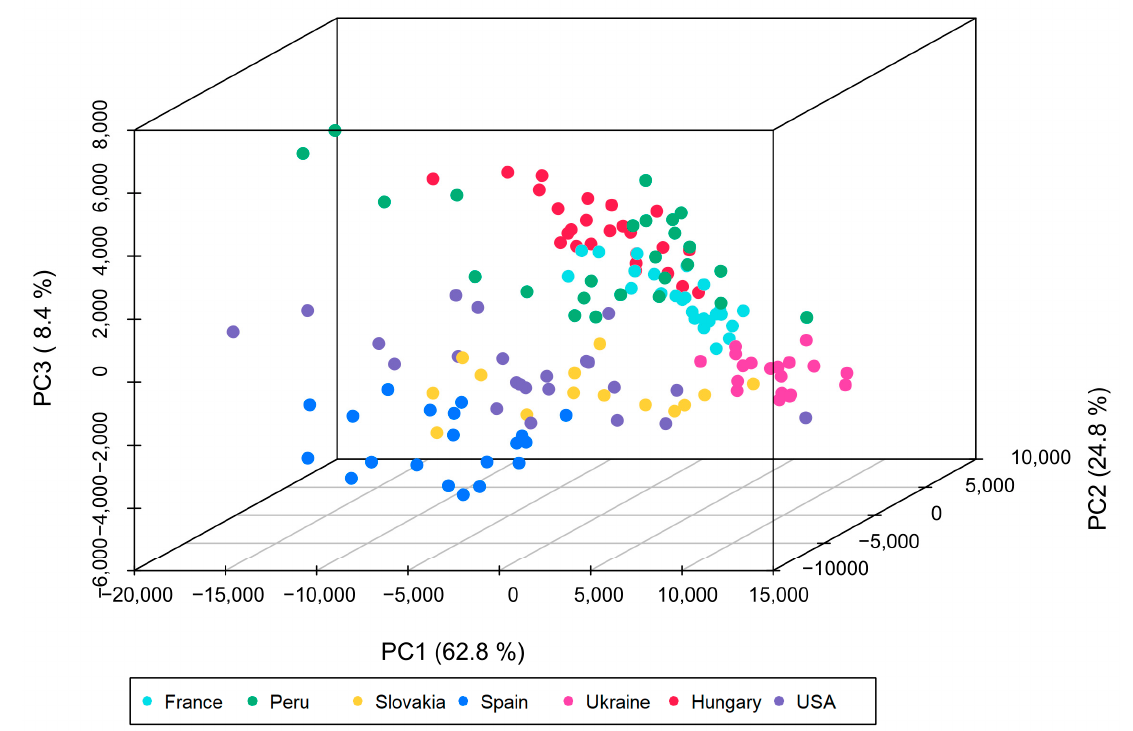
Figure 3. PCA scores plot created using peak areas of only the 20 high potential marker substances, after pareto scaling as preprocessing.